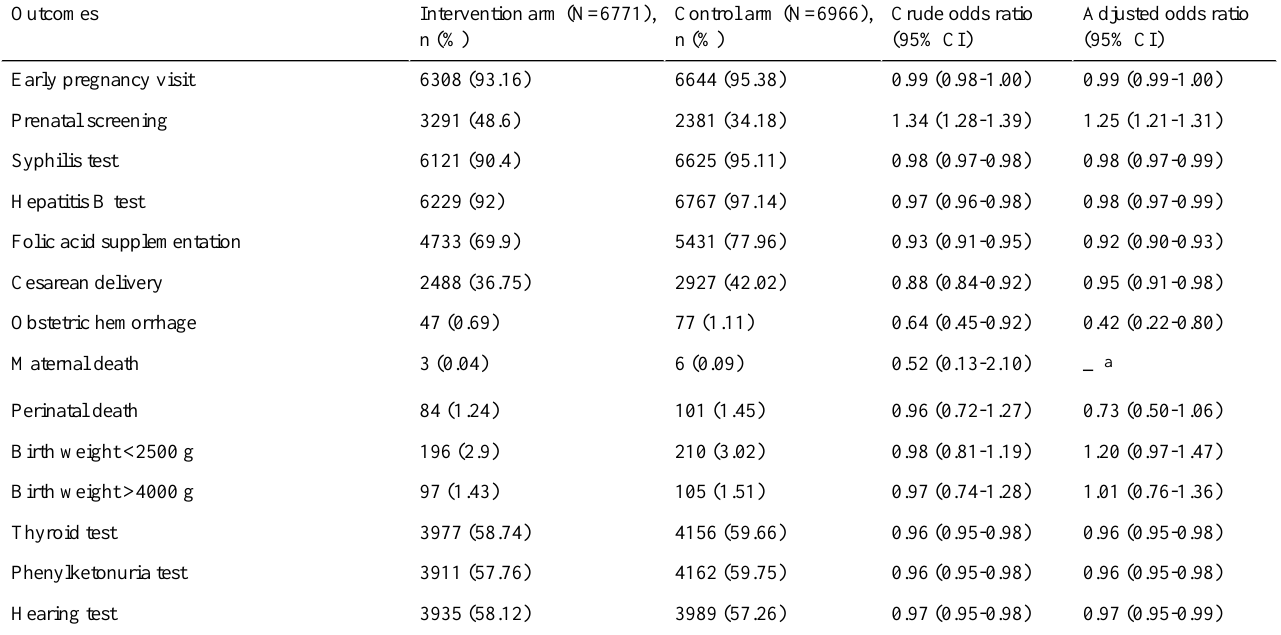
Table 3. Comparison of maternal and infant outcomes between the intervention and control arms at the individual level, Hunan, China, 2011-2012 (adjusted for gravidity, parity, residence, household income, high-risk pregnancy status, and gender of